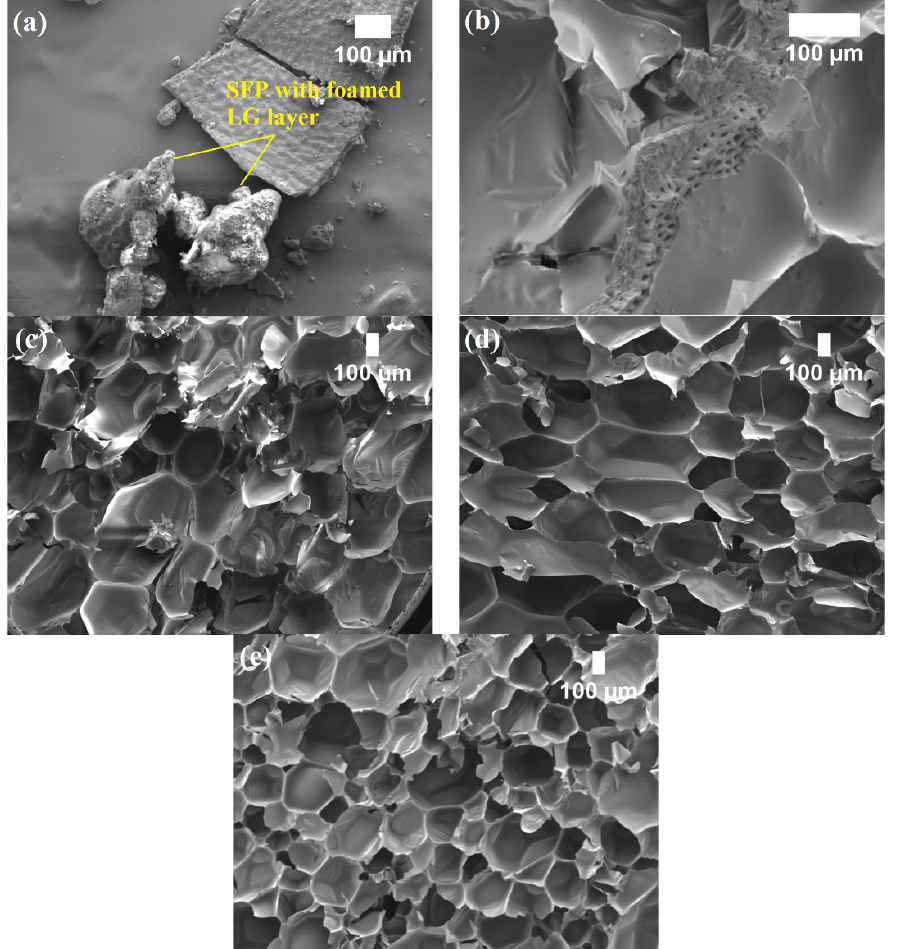
Figure 1. LG-modified SFP filler in PUR matrix: ( a ) LG-modified SFP filler (magnification × 100); ( b ) LG-modified SFP filler in PUR foam matrix (magnification × 200); ( c ) SFP-10/LG sample matrix (magnification × 40); ( d ) SFP-20/LG sample matrix (magnification × 40); and ( e ) SFP-30/LG sample matrix (magnification × 40).